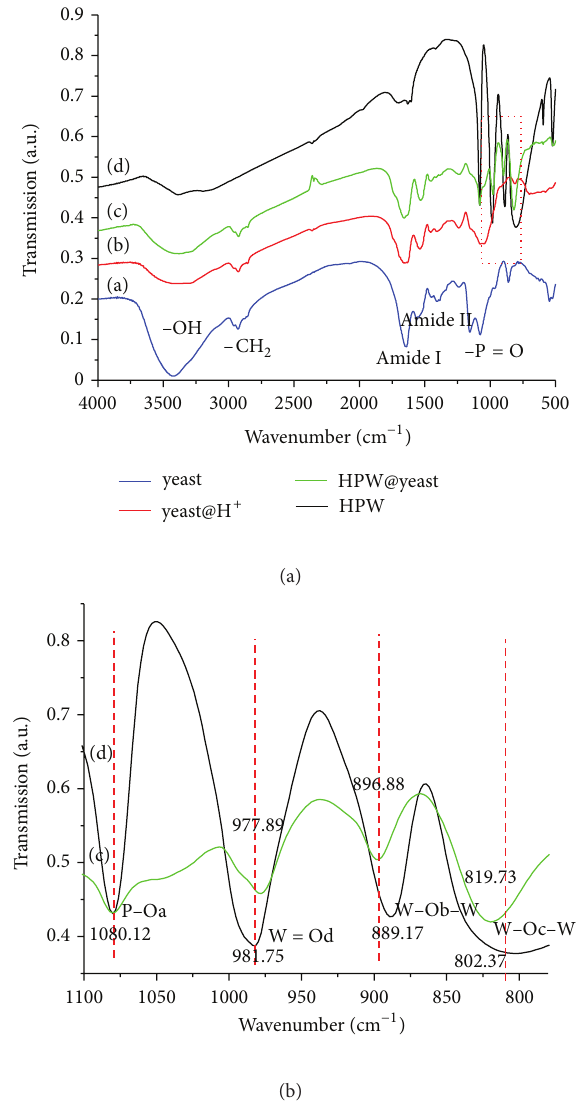
Figure 5: FT-IR spectra of (a) pristine yeast, (b) yeast treated by H 2 SO 4 solution, (c) HPW@yeast microspheres, and (d)